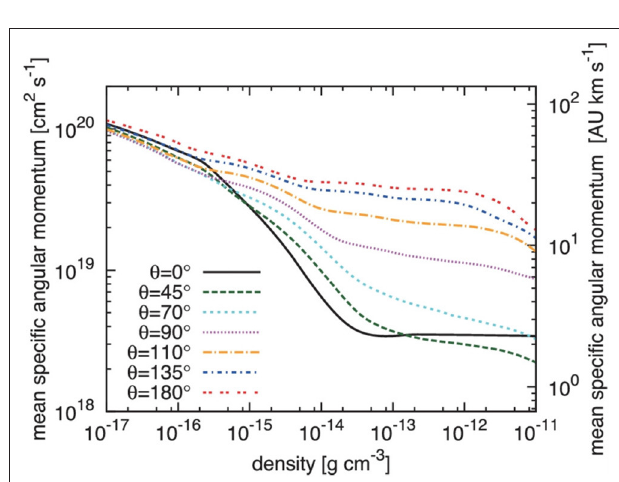
FIGURE 10 | The angular momentum in the first hydrostatic core which collapses to form a disc for non-ideal MHD models at various angles θ between the rotation axis and magnetic field vector; θ = 0 ◦ represents the aligned case. Except for the θ = 90 ◦ case, the angular momenta are grouped around θ = 0 ◦ and θ = 180 ◦ , suggesting a bi-modality in disc sizes. This figure is Figure 6 of Tsukamoto et al. (2017), and is reproduced with